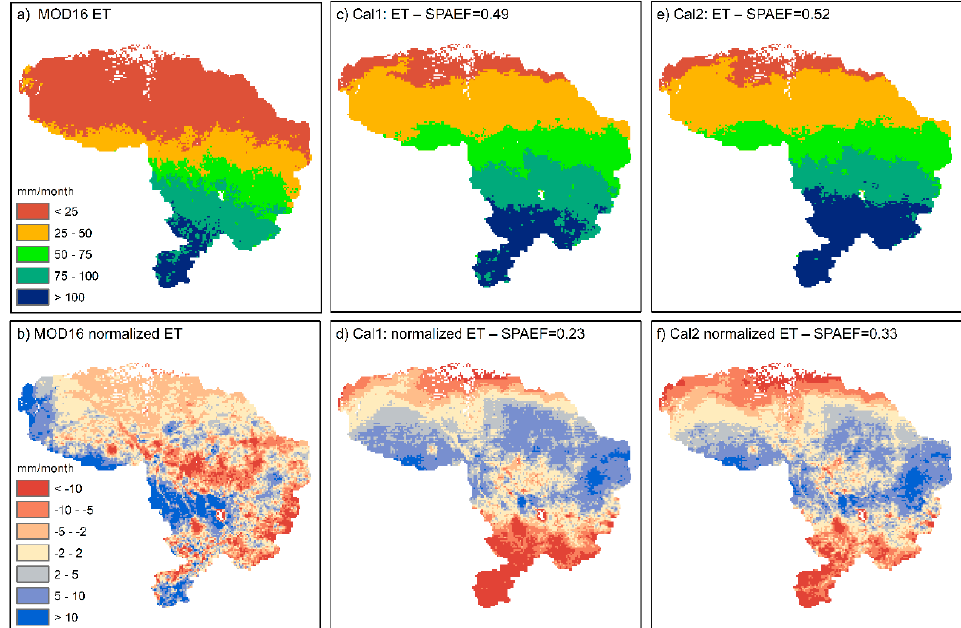
Figure 8. Example of simulated ET (mHM) and the applied precipitation based normalization method. The fitted polynomial model using observed ET (red) is shifted to account for the model bias (blue).